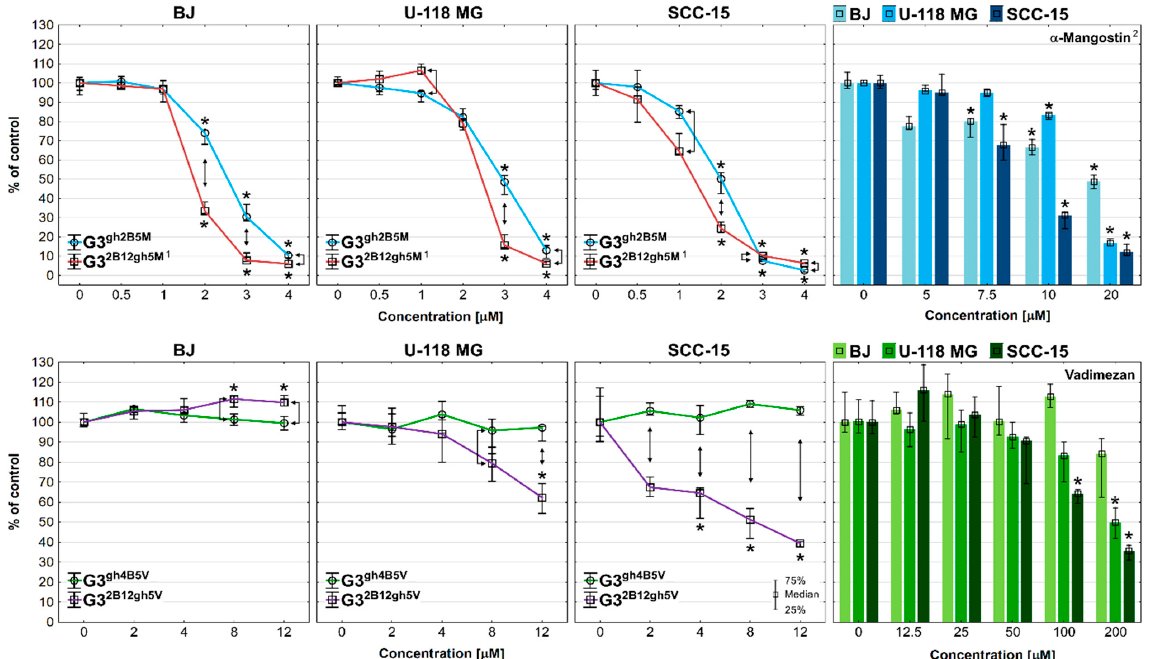
Figure 5. Anti-proliferative effect of G3 gh2B5M , G3 2B12gh5M , G3 gh4B5V , G3 2B12gh5V , α M, and V on BJ, U-118 MG, and SCC-15 cells after 72 h of incubation, determined with Hoechst 33,342 staining. Medians of the fluorescence signal (expressed as percent of the non-treated control), indicating the cell num- ber in a well, are plotted. The whiskers indicate lower (25%) and upper (75%) quartile ranges. * p ≤ 0.05; Kruskal-Wallis test (against non-treated control), ↕ p ≤ 0.05; Mann-Whitney U test (ester against amide-attached drug-conjugate). 1,2 Data for G3 2B12gh5M conjugate and α M were reproduced from [29] and [2], respectively.